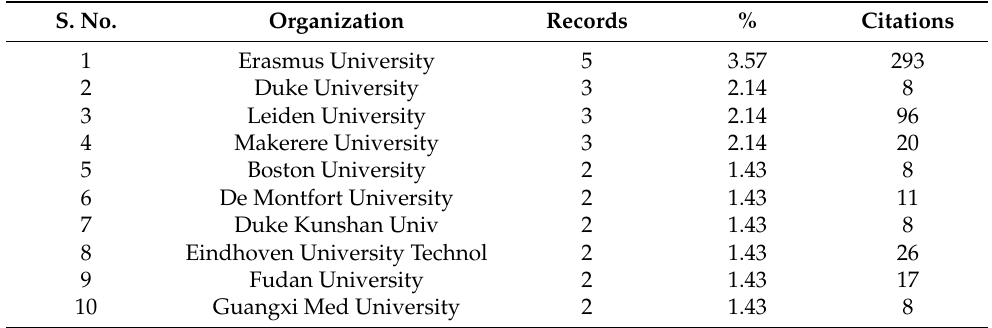
Table 6. Number and share of international collaboration articles of organizations produced by the top ten most productive universities in health sciences